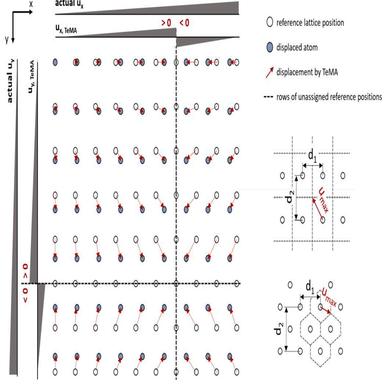
Nearest neighbor assignment of displaced atoms and reference lattice positions for a rectangular lattice projection leading to discontinuities of resulting displacements in x- and y-direction. The schematics to the right illustrate the shape of the Wigner-Seitz cells (rectangle or hexagon) leading to different maximum definite displacements in dependence of the crystal structure and zone axis contemplated (see text for details).